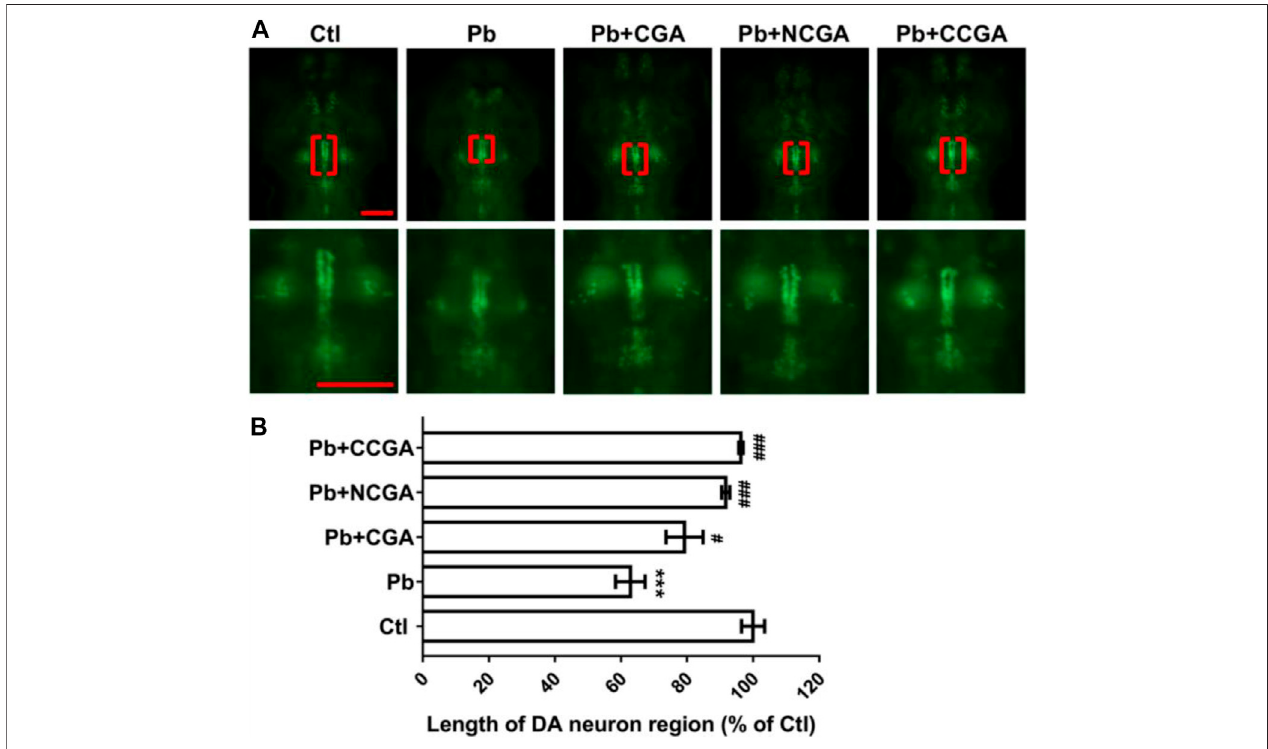
FIGURE 3 | Representative images of DA neuron of zebra fi sh and its analysis. (A) Representative fl uorescence microscopy images of vmat2:GFP zebra fi sh at 120 hpf. DA neurons were indicated by the red brackets. Enlarged images are shown to improve visualization of DA neuron morphology (scale bar, 100 μ m). (B) Statistical analysis of the length of the DA neuron region ( n (cid:1) 6); *** p < 0.001 vs. control and # p < 0.05, ### p < 0.001 vs.